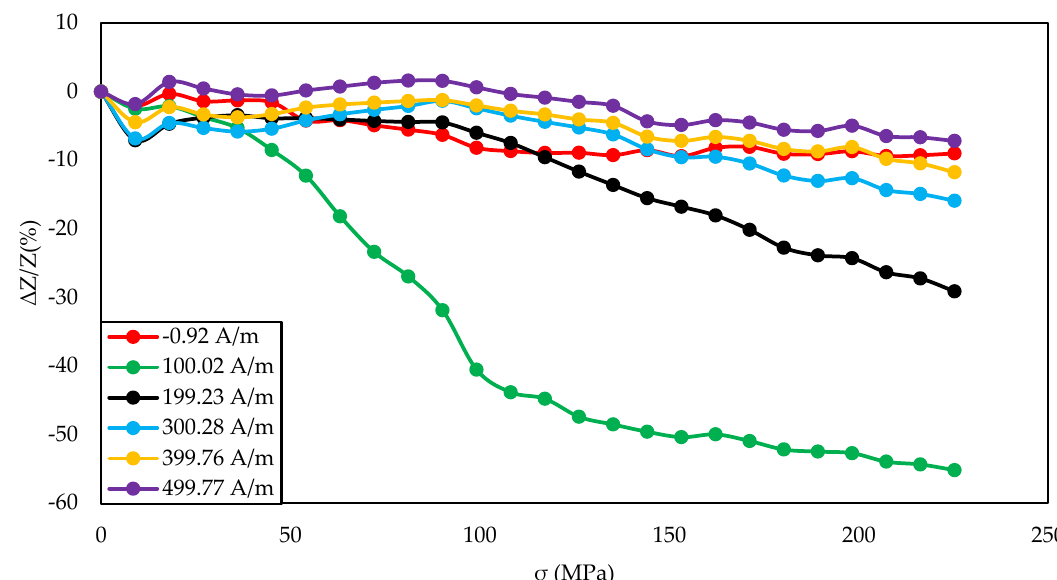
Figure 6. Dependence of impedance in a function of stresses for different magnetizing fields for the annealed by a 700 mA current sample.